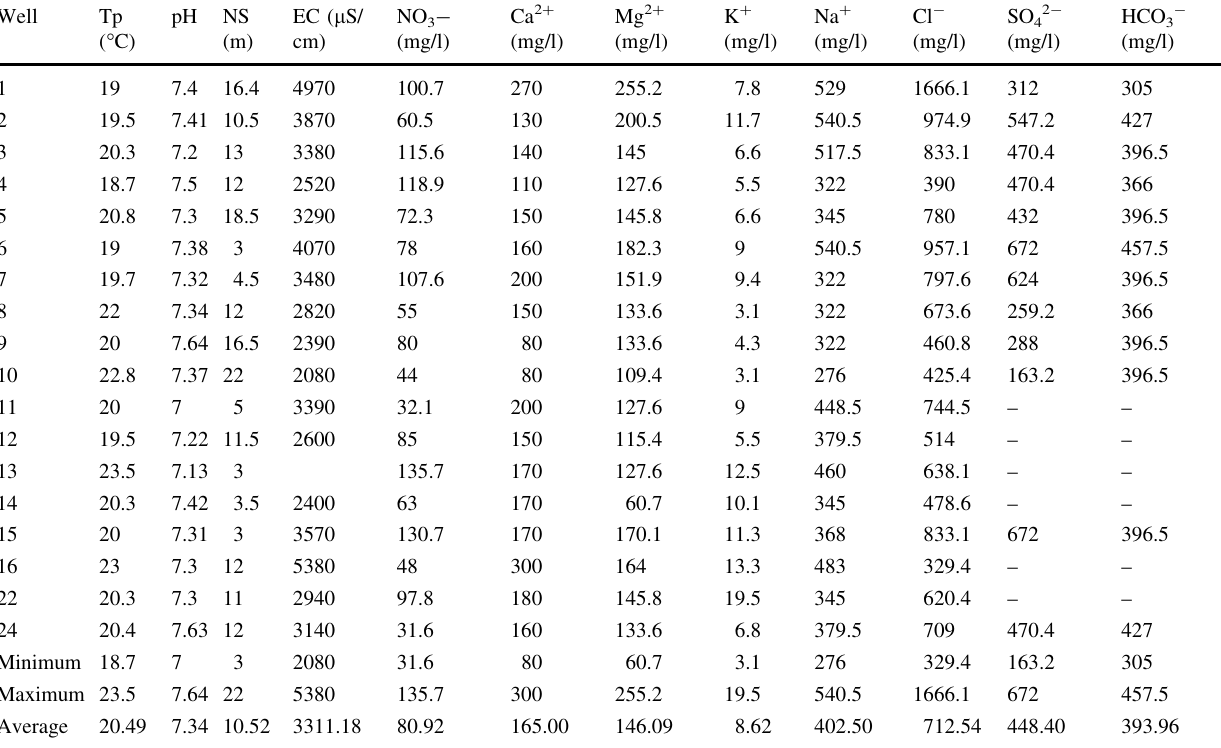
Table 2 Physicochemical parameters of groundwater sampled in the wells in March 2013 (NS: Static level) Well Tp ( (cid:3)